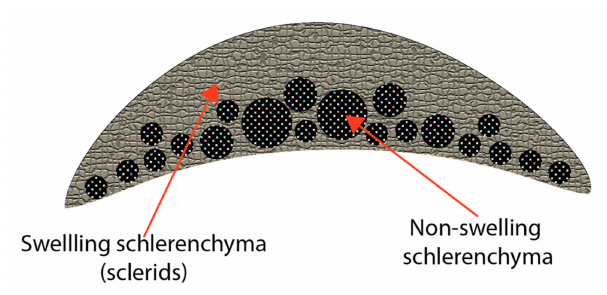
Figure 3. Stylised representation of pinecone bract cross section illustrating the location and distribution of the two types of schlerenchyma fibre.